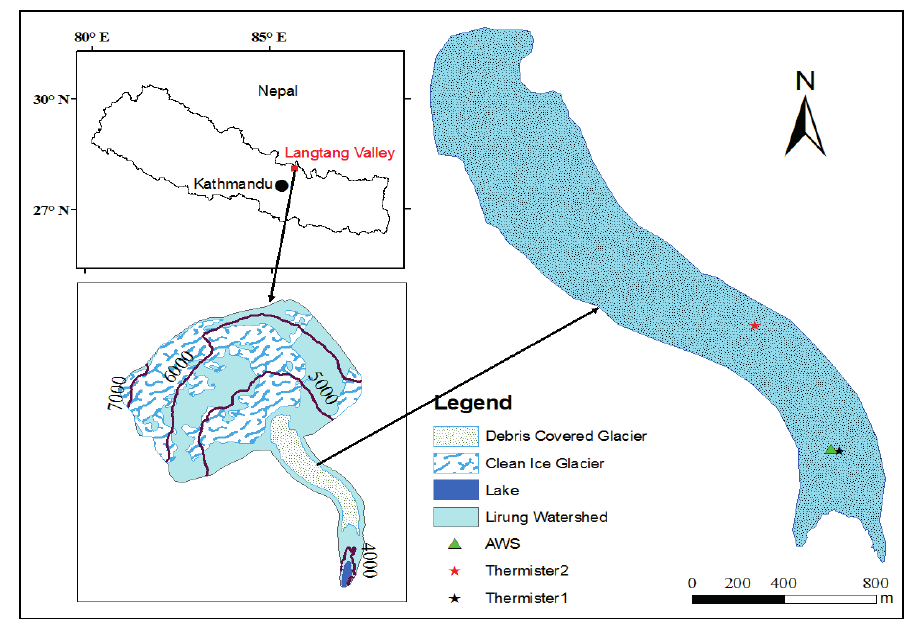
Fig. 1 Location map of study area showing location of AWS and thermistors in the glacier.